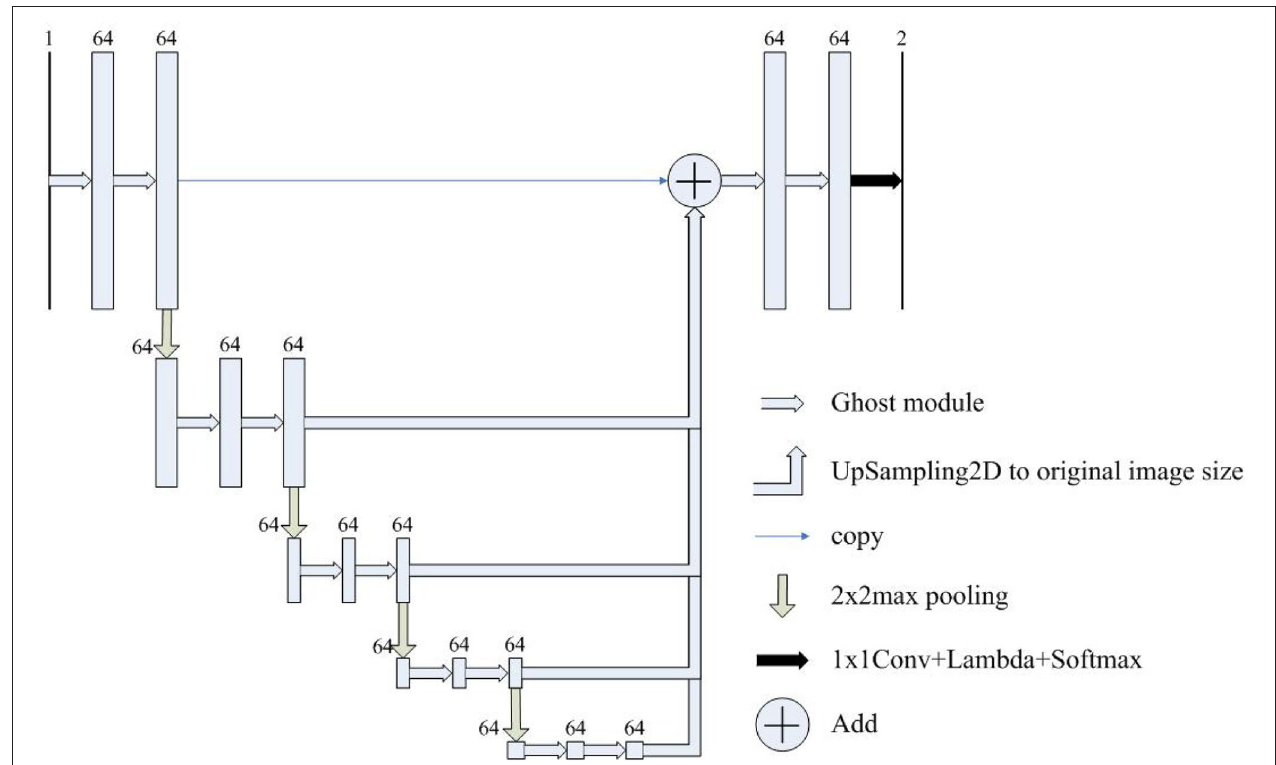
FIGURE 3 | The architecture of Half-UNet. The input image size is detailed in Table 2 . The numbers above the rectangles represent the number of feature map channels.